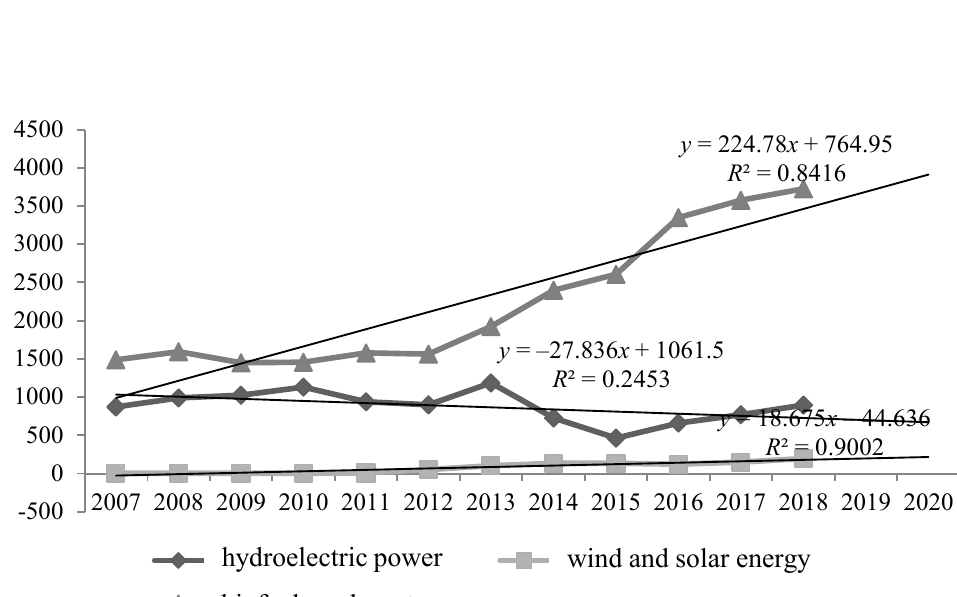
Fig. 3. Production of energy from renewable sources, thousands of tons o.